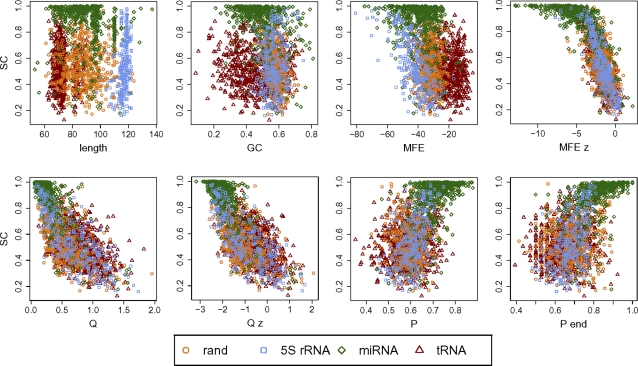
Comparison of SC with other RNA measures.Scatter plots showing self-containment index plotted against eight other RNA measures: sequence length (length); proportion of G and C nucleotides (GC); minimum free energy of the structure (MFE); z-score of the mfe compared to 1,000 dinucleotide-shuffled sequences (MFE z); normalized Shannon entropy of base-pair probabilities among all the structures in the thermodynamic ensemble (Q); z-score of Q compared to 1,000 dinucleotide-shuffled sequences (Q z); proportion of bases involved in base pairs over the entire structure (P); and proportion of bases involved in base pairs, limited to the 5′ and 3′ ends of the sequence. Four sets of RNAs are overlaid in each plot: tRNAs, random structures, 5S rRNAs, and human pre-miRNAs.